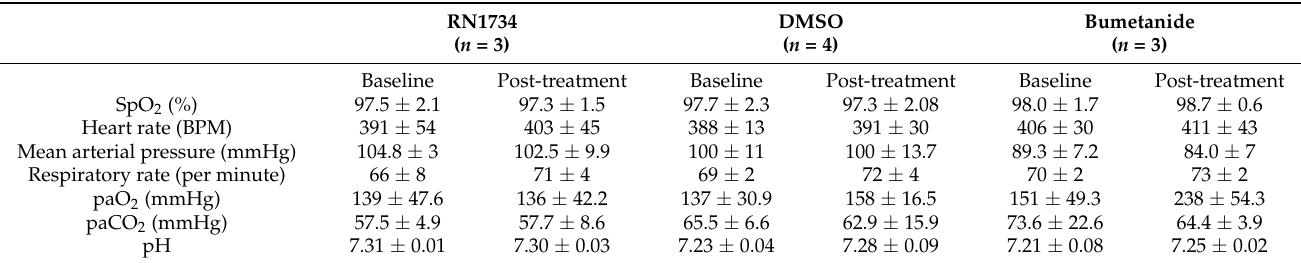
Table 1. Physiological parameters before and after drug administration for each group. Comparisons between baseline and post-treatment were carried out using paired Student’s t